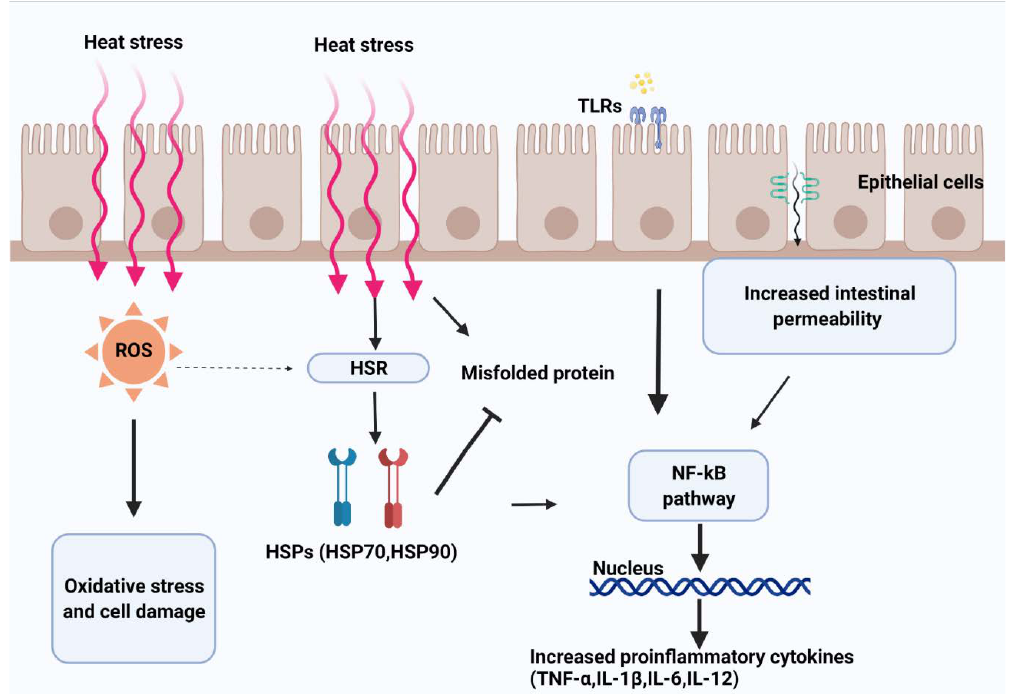
Figure 2. Heat leads to splanchnic hypoxia and metabolic stress. Heat and hypoxia increase the production of oxidants (e.g., reactive oxygen species (ROS)), consequently activating the heat shock response pathway (HSR) to maintain homeostasis. Higher exposure to oxidants increases epithelial permeability by disrupting tight junction proteins. Increased permeability of the intestinal mucosa mediates the passage of luminal contents (e.g., endotoxins and bacteria), activating the immune response mediated by the Toll-like receptor (TLR) signaling pathway and contributing to the host defense